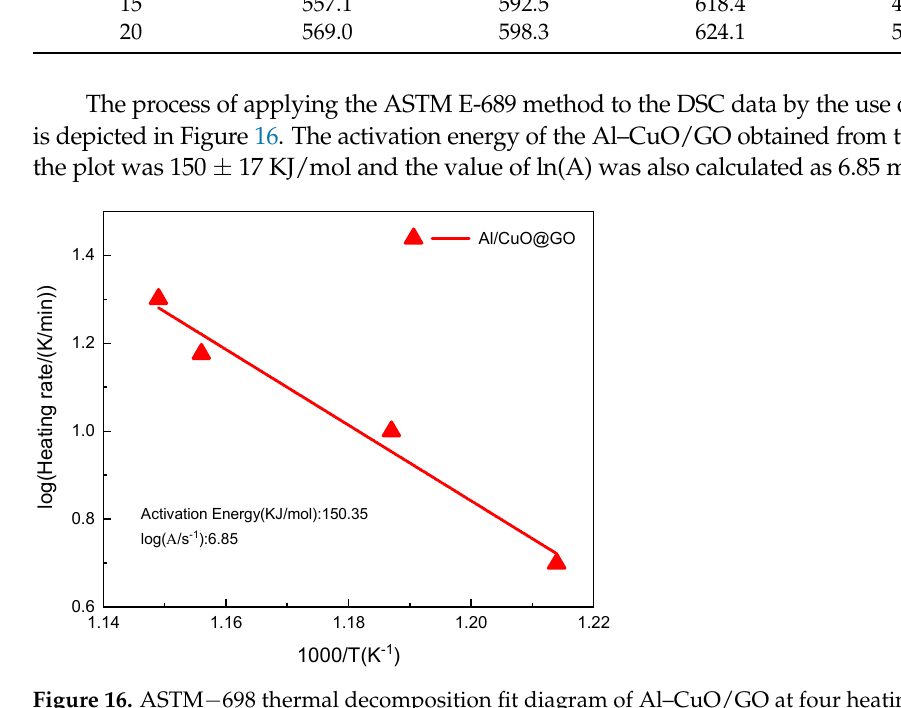
Figure 16. ASTM − 698 thermal decomposition fit diagram of Al–CuO/GO at four heating rates.